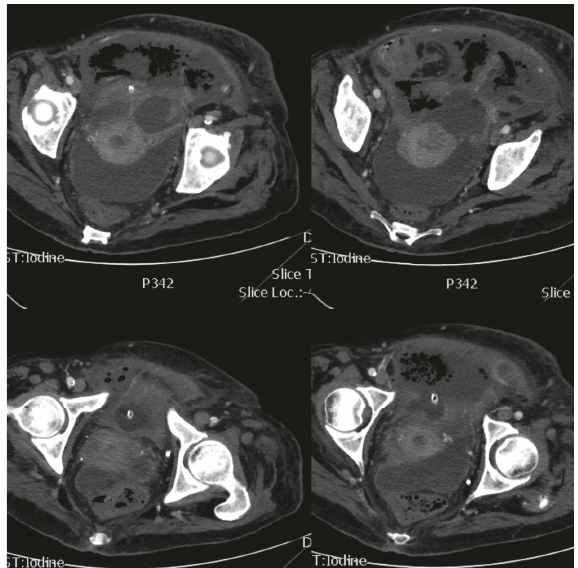
Figure 1: Abdominal CT scan images revealing the presence of gas within the anterior bladder wall and retropubic space. The anterior bladder wall is not enhanced by contrast material.